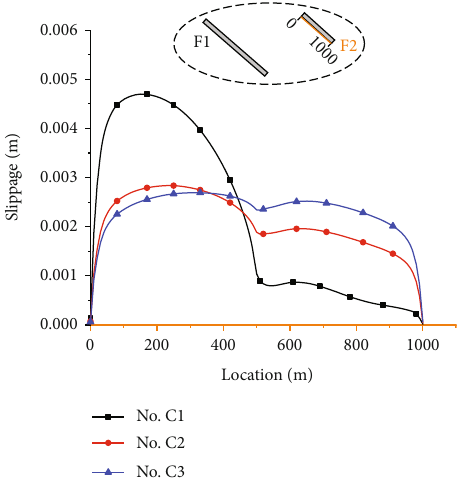
Figure 10: The fault slippage of F2 according to di ff erent fracturing regions (Nos.